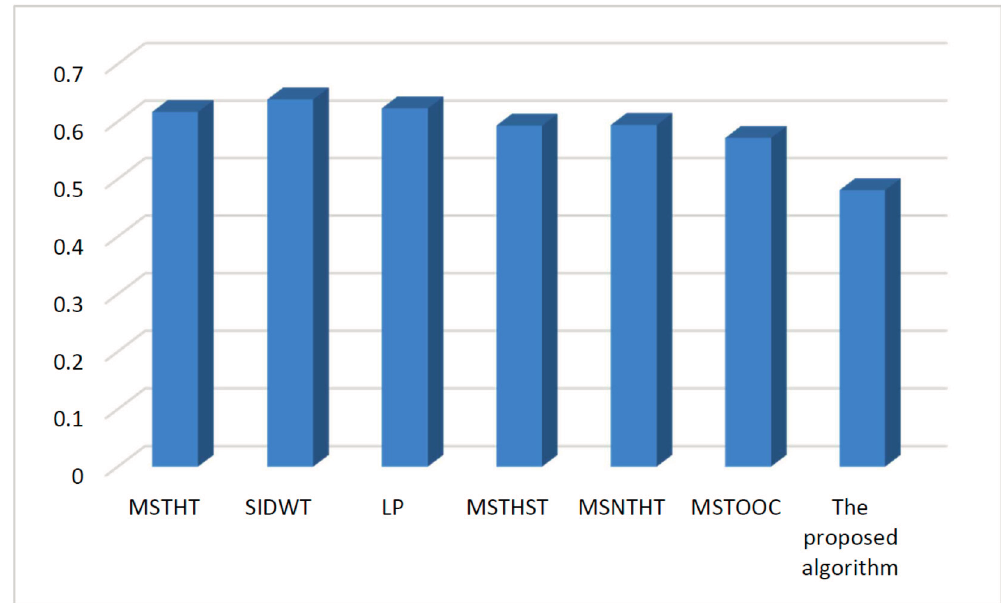
Figure 7. Quantitative comparison using measure